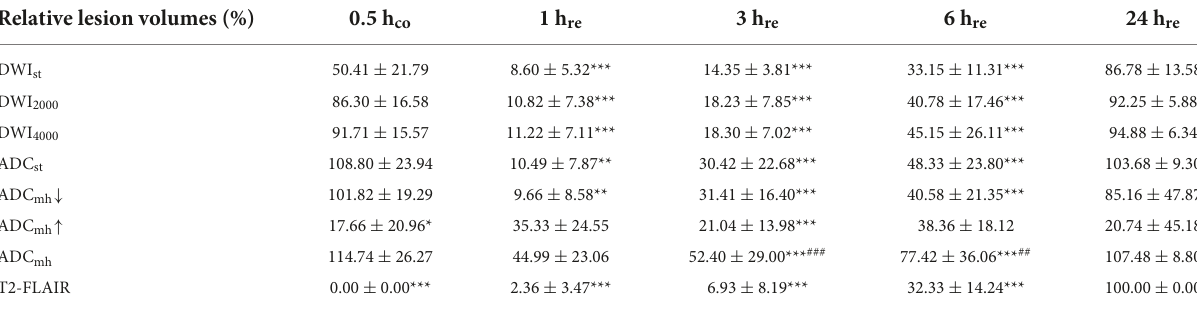
TABLE 2 Mean relative ADC (rADC) values at different time points (%).